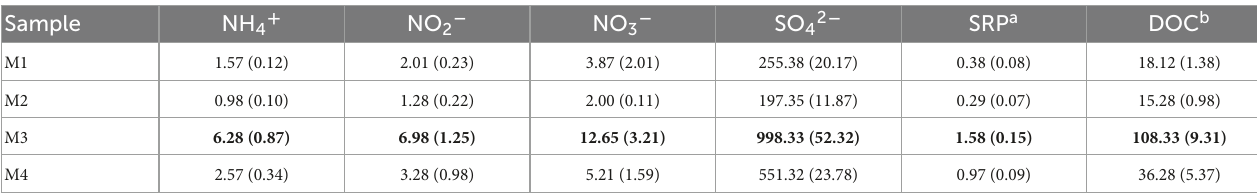
TABLE 1 Chemical analysis of soluble nutrients in meltwater. Sample